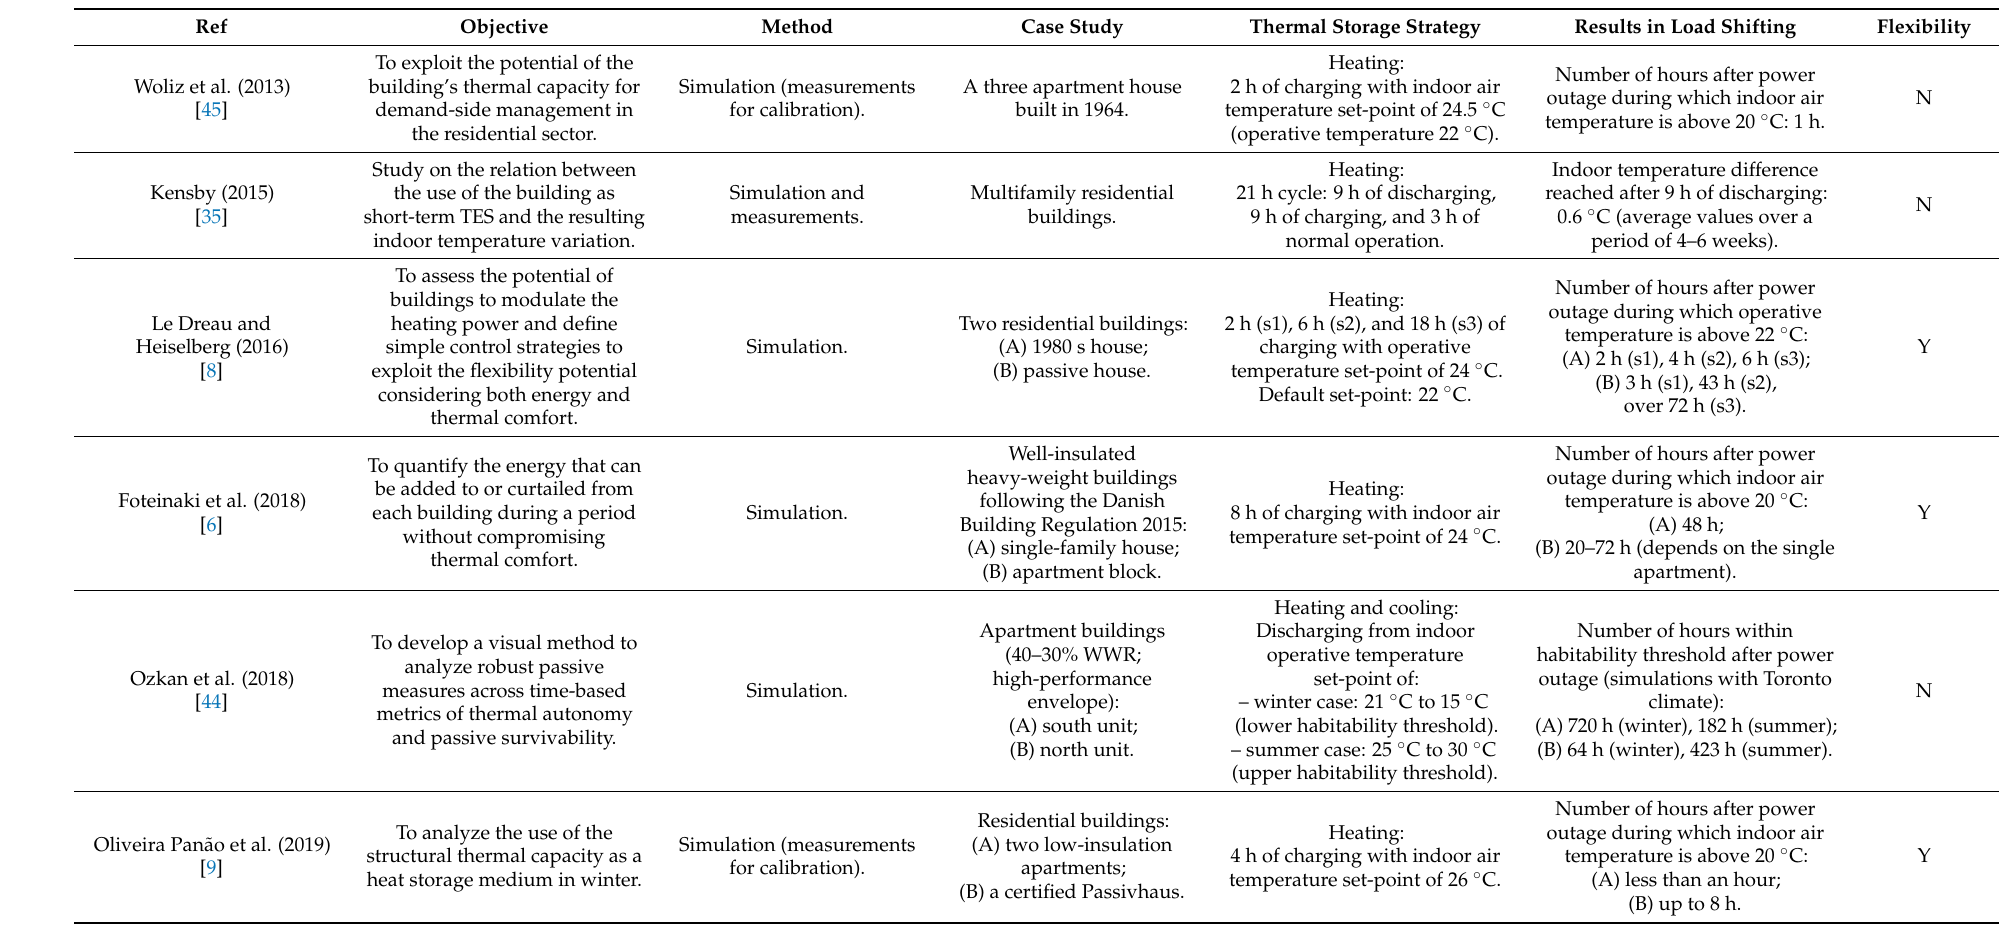
Table 1. Literature review on TES for energy